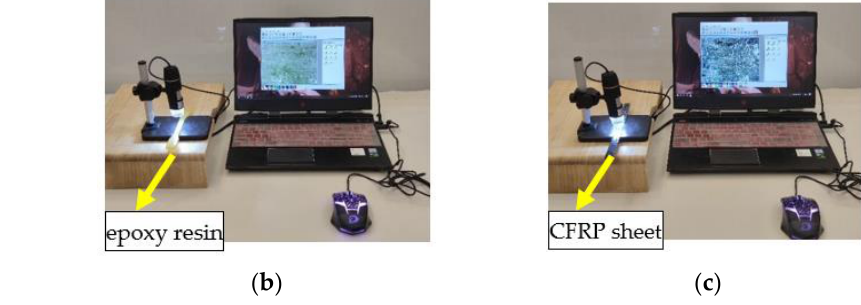
Figure 9. Microscopic observation: ( a ) concrete flexural specimen; ( b ) epoxy resin sheet; and ( c ) CFRP